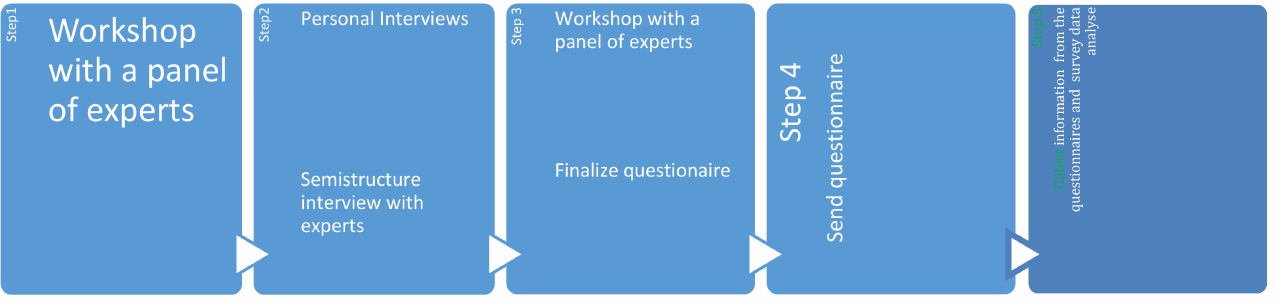
Figure 1. Five-step methodology (Source: own